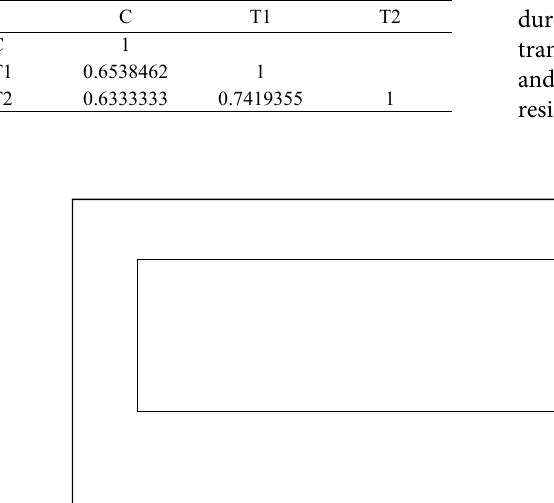
Table 4: Similarity matrix based on DIC similarity coefficient